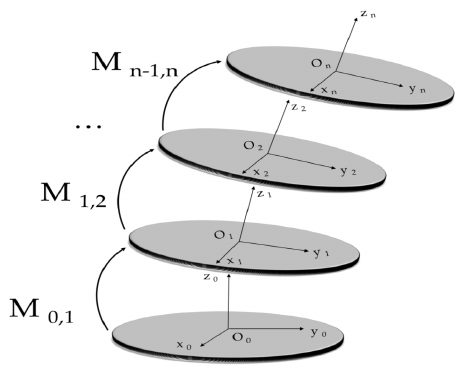
Figure 3. Homogeneous Transformation Matrix system composition of subsequent reference plane.